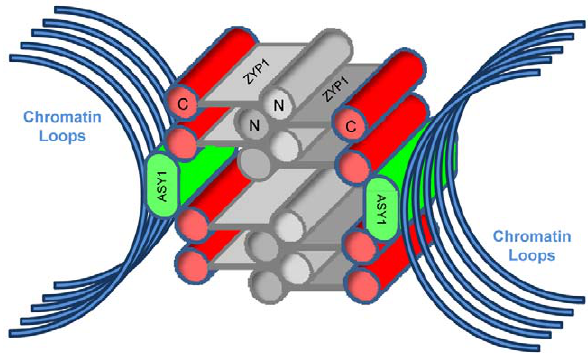
Figure 6. Proposed 3D model of the variant SC structure. Proposed 3D model of the variant SC structure based upon published information about ZYP1 and ASY1 proteins and the 3D-SIM images described in this study. Chromatin loops (blue) are shown to attach in the vicinity of the ASY1 protein (green). The C-terminus of the ZYP1 protein (red) is the epitope for its antibody. The precise location of the LEs is currently unknown, so they have been excluded from the